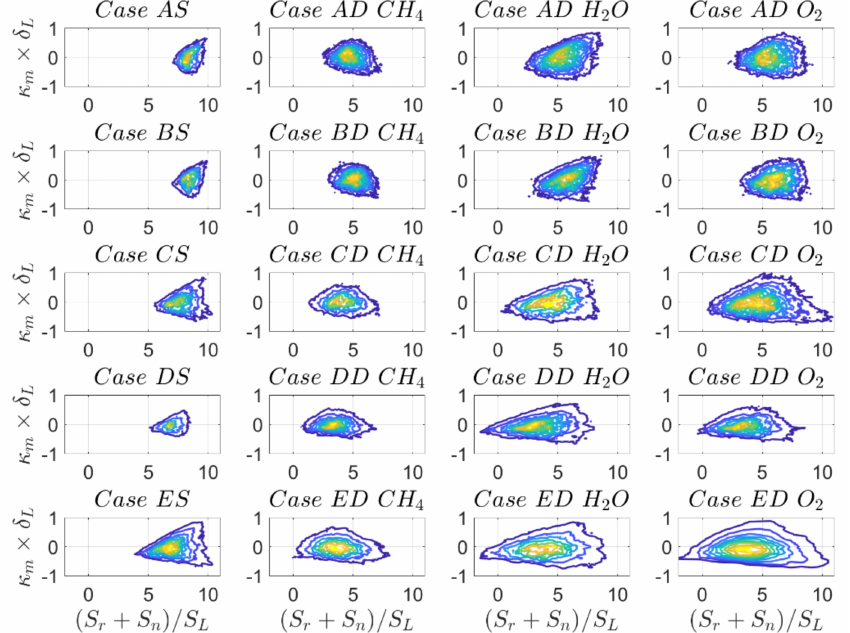
Figure 13. Joint PDF of normalised, combined reactive and normal diffusion component of dis- placement speed ( S r + S n ) / S L and normalised mean curvature κ m × δ L on c = 0.8 progress-variable isosurface for top to bottom cases A–E for (1st column) SC and (2nd to 4th column) DC simulations for reaction progress variable based on CH 4 , H 2 O,O 2 mass